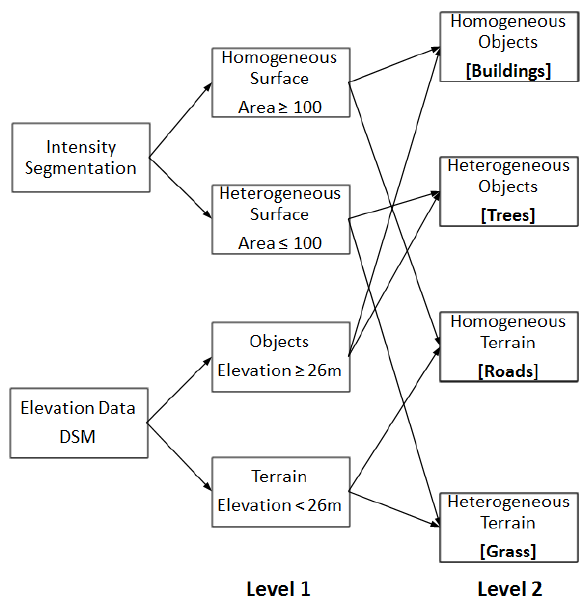
Figure 1: Object-Based Classification Decision